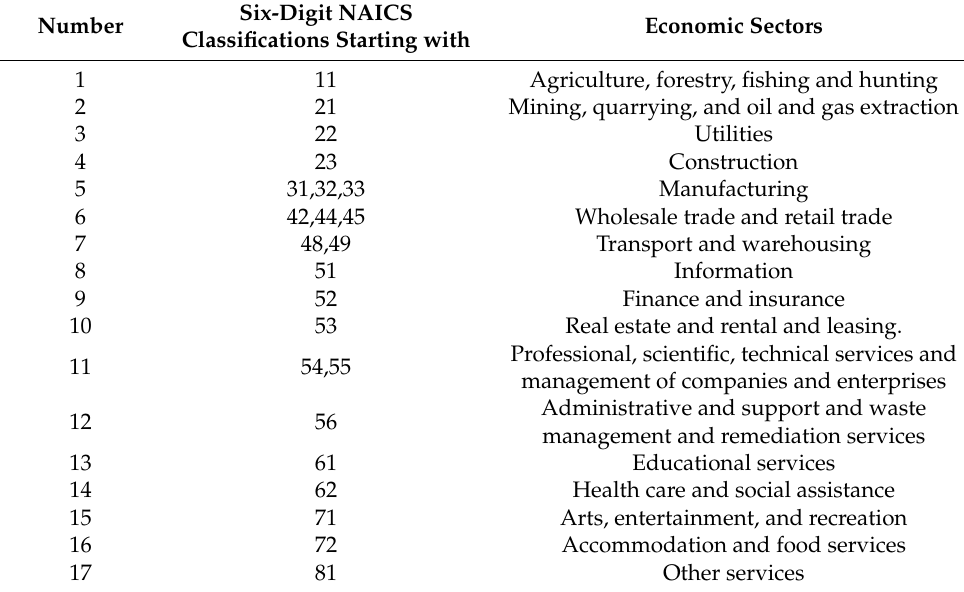
Table 1. The economic sectors based on the first two numbers of the six-digit North American Industrial Classification System [49] into which all micropolitan enterprises were classified before enumerating sector